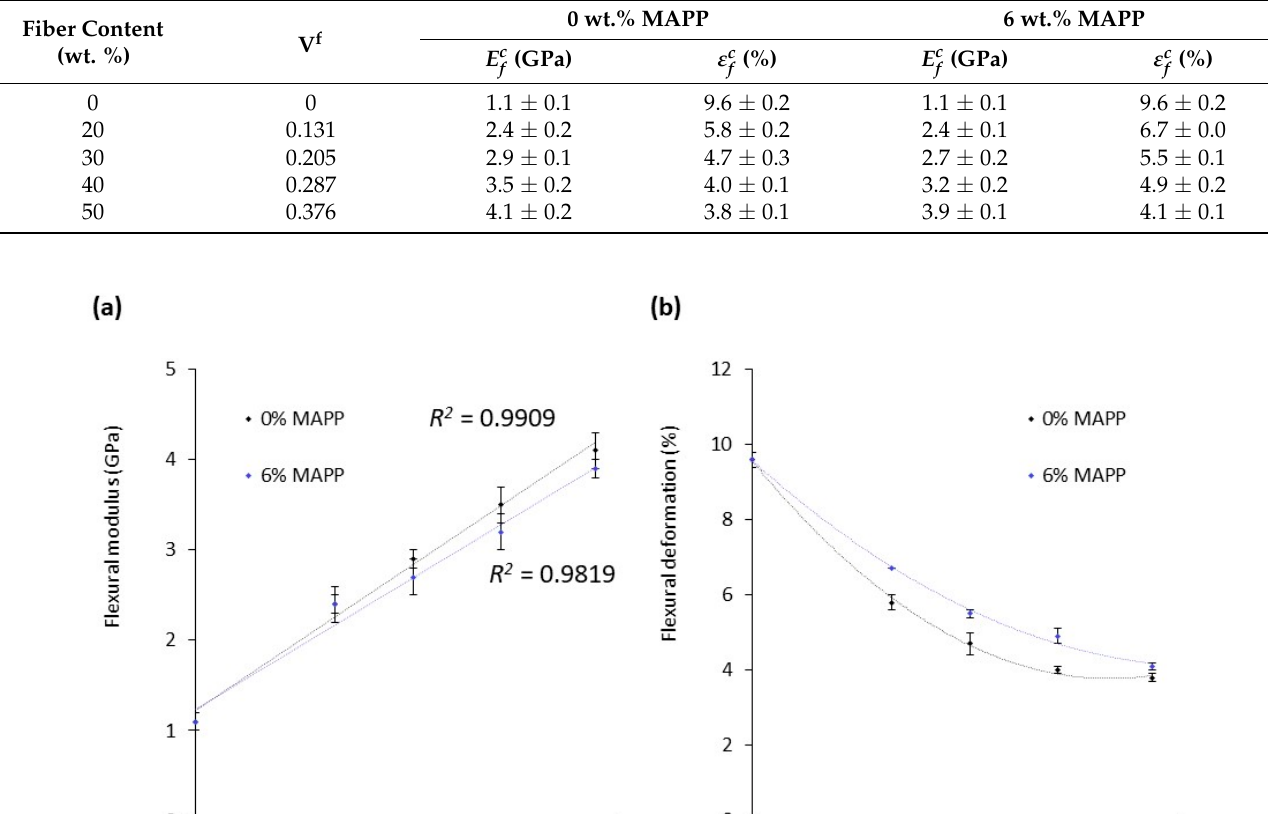
) and flexural deformation ( ε C f